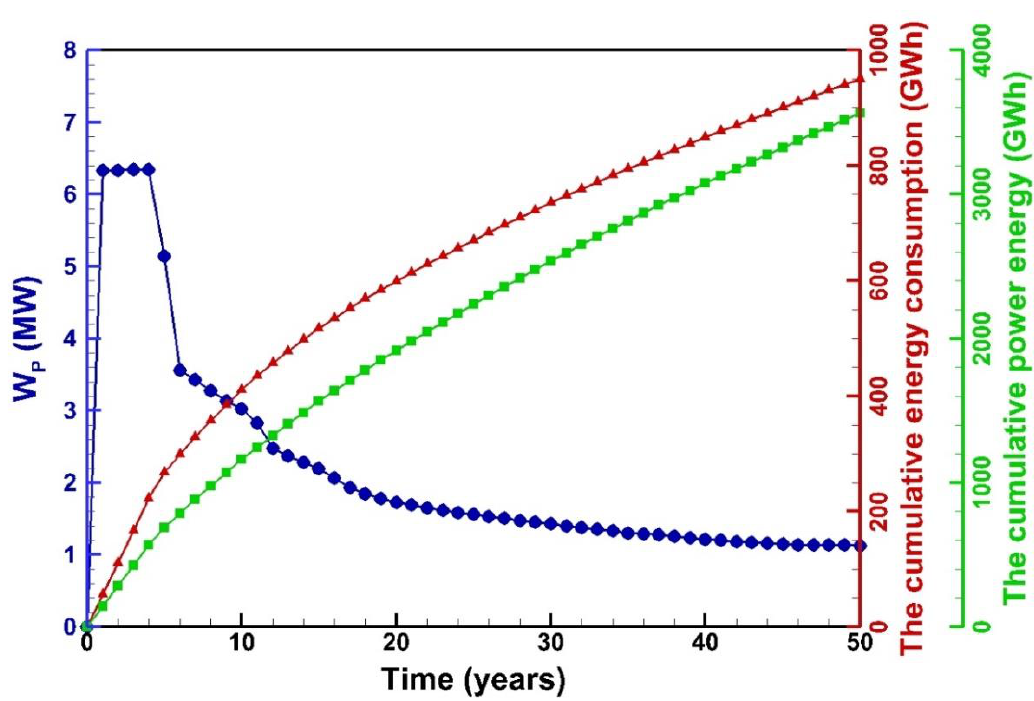
Figure 11. Evolution of the internal energy consumption and the cumulative energy consumption of the production pumps in 50 years lifetime.